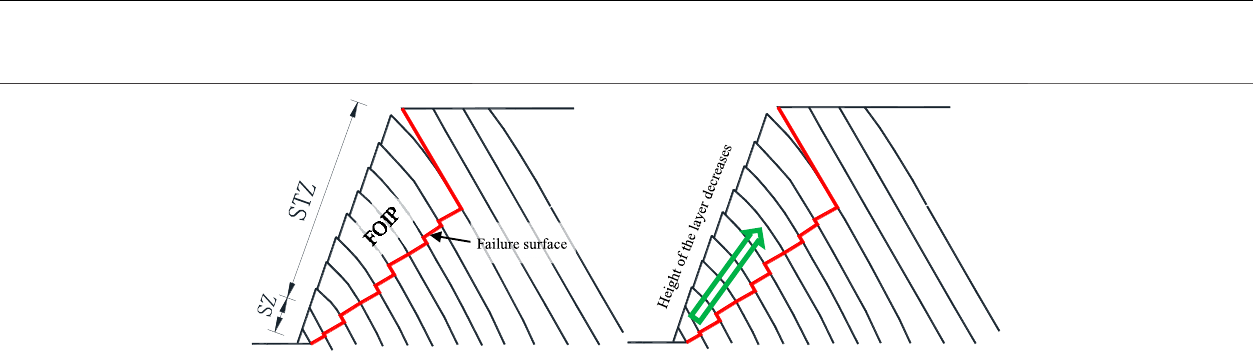
Frontiers in Earth Science |